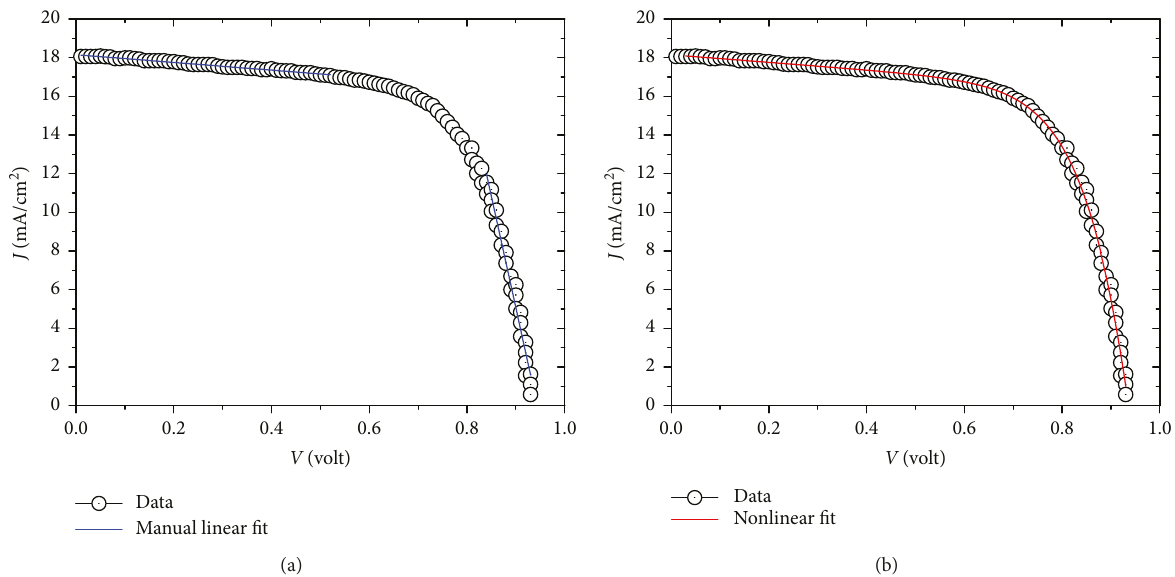
Figure 7: Fitting I-V curve perovskite solar cell based on mp-TiO